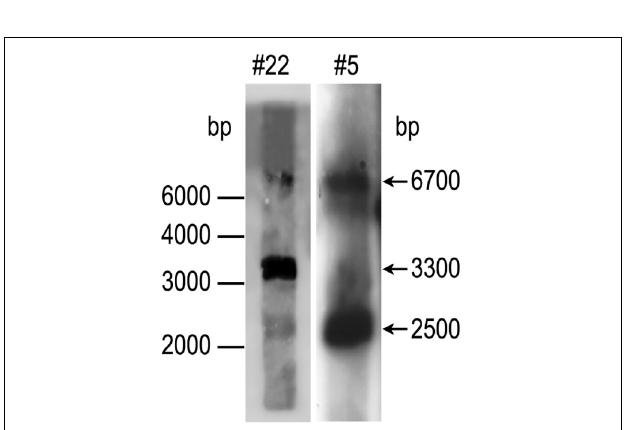
FIGURE 4 | Southern blot analyses of genomic DNA of transformed KM71- tmf A and KM71- gfp-tmf A cells. The blots were probed with AOX 1 (left blot) and gfp (right blot) generated by PCR ( Table 1 ). The size of DNA markers is given on the right and the sizes of the digested DNA bands is indicated with arrows on the left. The Southern blot was repeated a second time showing the same results.